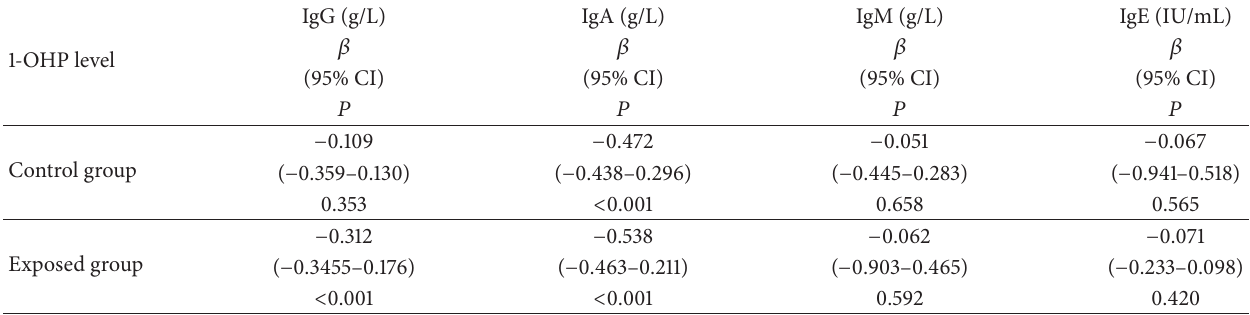
Table 3: Dose-response relationship with the levels of 1-OHP with immunoglobins.